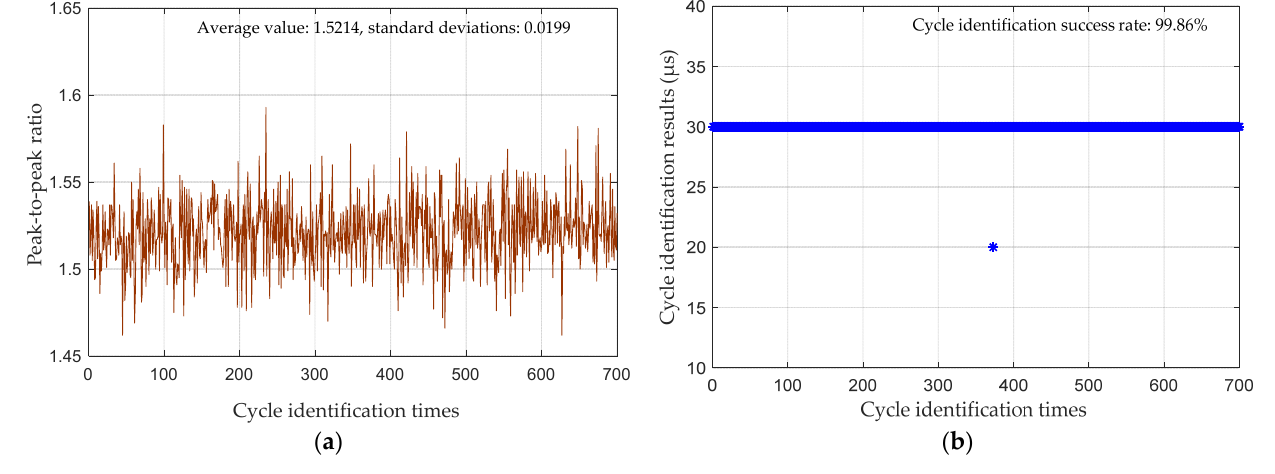
Figure 15. Results of cycle identification for Test 1: ( a ) peak–peak ratio; ( b ) cycle identification result.